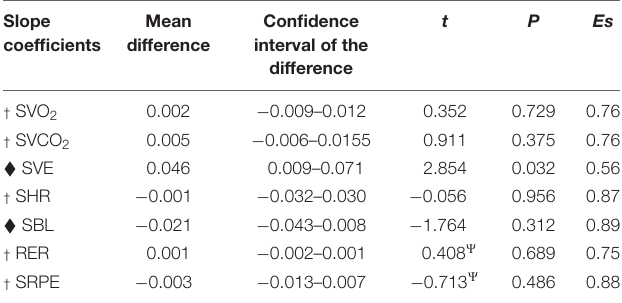
TABLE 4 | Paired samples t -test comparison between vibration and no vibration conditions. Slope Mean Confidence coefficients difference interval of the